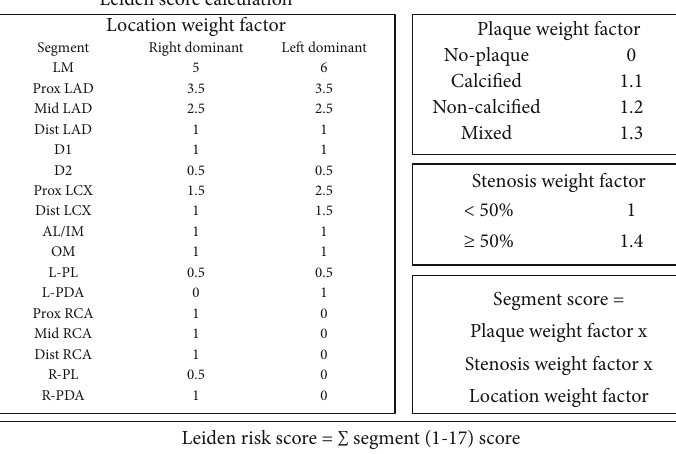
Figure 1: Schematic overview of the computed tomography angiography-derived risk score. Leiden score is calculated by the summation of segment score quanti fi ed as plaque weightfactor × stenosisweightfactor × locationweightfactor , i.e., a right dominant system with a noncalci fi ed plaque with > 50% stenosis in the left main segment ( 5 × 1 : 2 × 1 : 4 ) +a noncalci fi ed plaque with < 50% stenosis in the proximal left circum fl ex artery ( 1 : 5 × 1 : 2 × 1 ) +a calci fi ed plaque with > 50% stenosis in the right posterior descending artery ( 1 × 1 : 1 × 1 : 4 ), so the Leiden score is 11.74. Segment involvement score (SIS) was calculated by the summation of the segments exhibiting plaque; in the case above, SIS is 3. CTA=computed tomography angiography; AL =anterolateral segment; D1=diagonal 1; D2=diagonal 2; IM = intermediate segment; LAD =left anterior descending coronary artery; LCA =left coronary artery; LCX =left circum fl ex coronary artery; LM=left main segment; L-PDA =left posterior descending artery; L-PL=left posterolateral segment; OM =obtuse marginal segment; RCA=right coronary artery; R-PDA=right posterior descending artery; R-PL =right posterolateral